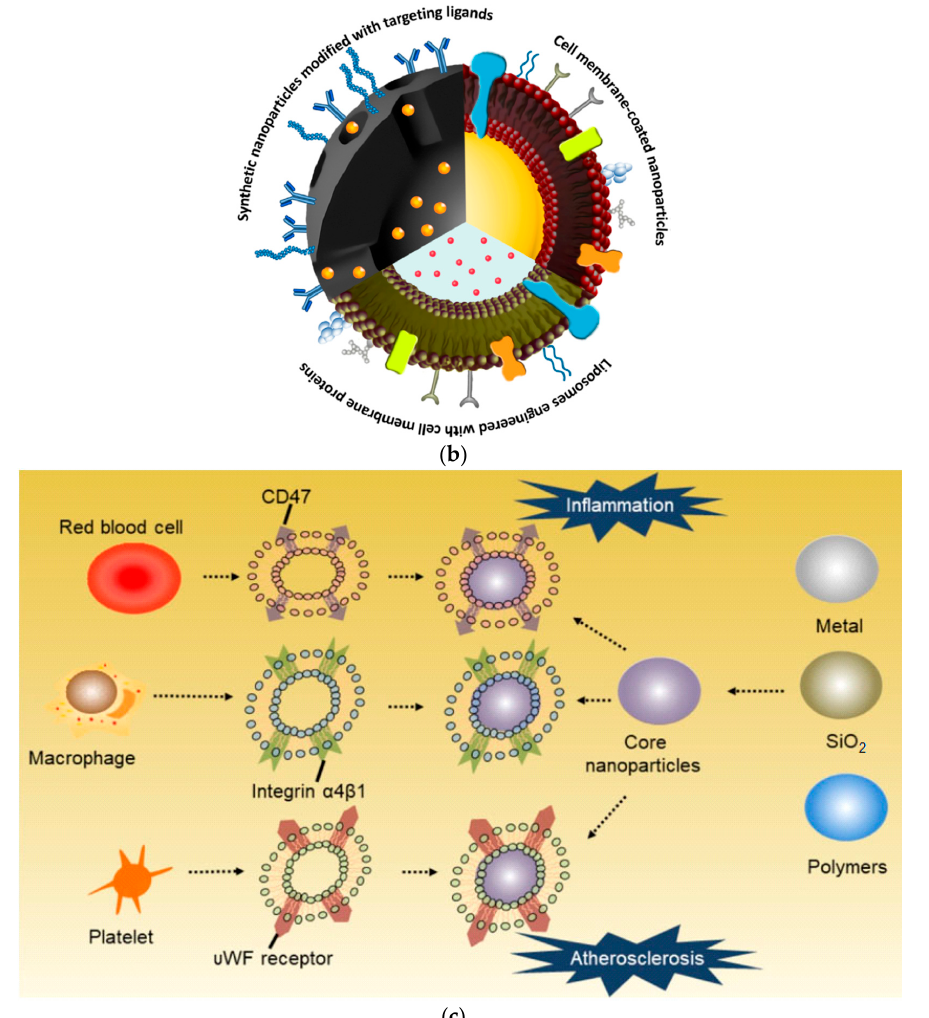
Figure 1. Biomimetic nanoparticles for biomedical applications. ( a ) Technology evolution: Early generations of particles were biologically inert and covered with nonfouling coatings, preventing their nonspecific interactions with the cells they encountered in vivo . From here, the next generation of nanoparticles became active, targeting molecules, which enabled the nanoparticles to reach the disease site and engage with the local environment. Taking inspiration from nature, the third gen ‐ eration of cell ‐ membrane ‐ based biomimetic nanoparticles mimicked the surface features of native cells by utilizing the whole cell membrane or membrane protein functionalization onto synthetic carriers (Reprinted from [31], license CC BY 4.0.) ( b ) Schematic presentation of different strategies of inflammation ‐ targeting biomimetic nanoparticles. Orange and red spheres represent drug ‐ encap ‐ sulated synthetic nanoparticles (grey) and liposomes (green), respectively. (Reprinted from [16], li ‐ cense CC BY 4.0.) ( c ) An example of modern BNM concept implementation: cell ‐ membrane ‐ coated NPs designed for atherosclerosis and inflammation therapy. The membranes of RBCs, platelets, and macrophages are extracted and used to coat different kinds of NPs depending on the site of inflam ‐ mation and atherosclerosis. Each cell membrane has its own unique surface proteins, such as CD47 on RBC, integrin a4b1 on macrophages, and GPIIb/IIa on platelets, modifying the therapeutic effects. (Reprinted from [20], license CC BY 4.0.)